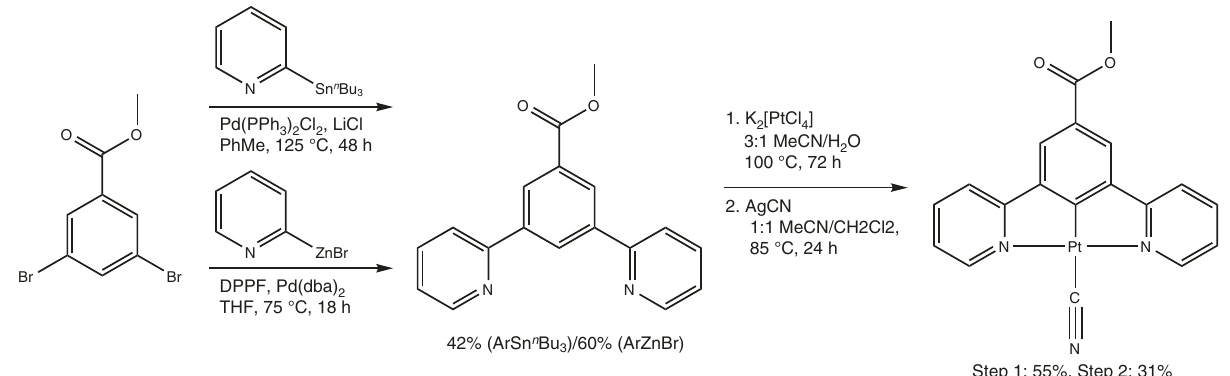
Fig. 2 Synthesis of Pt-pincer complex 1 . Two alternative routes for preparing the pincer ligand methyl 3,5-di(2-pyridyl)benzoate were tested, based on Stille (top) and Negishi (bottom) coupling